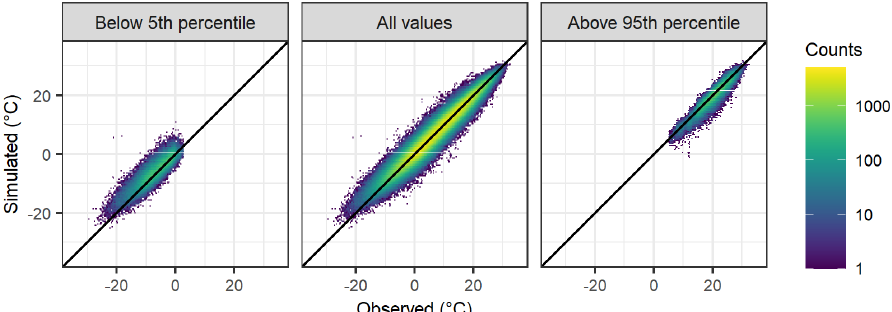
Figure 5. Distribution of simulated and observed daily mean temperature values for all station sites in the study region over the period 1980–2018. The three panels report the comparison by considering only values below the 5th percentile, all values and only values above the 95th percentile.